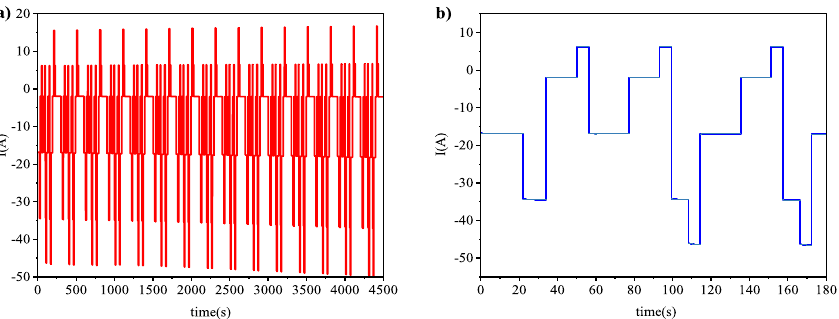
Figure 19. ( a ) DST working condition and ( b ) Discharge current. Table 9. Discharge equalization experimental data.